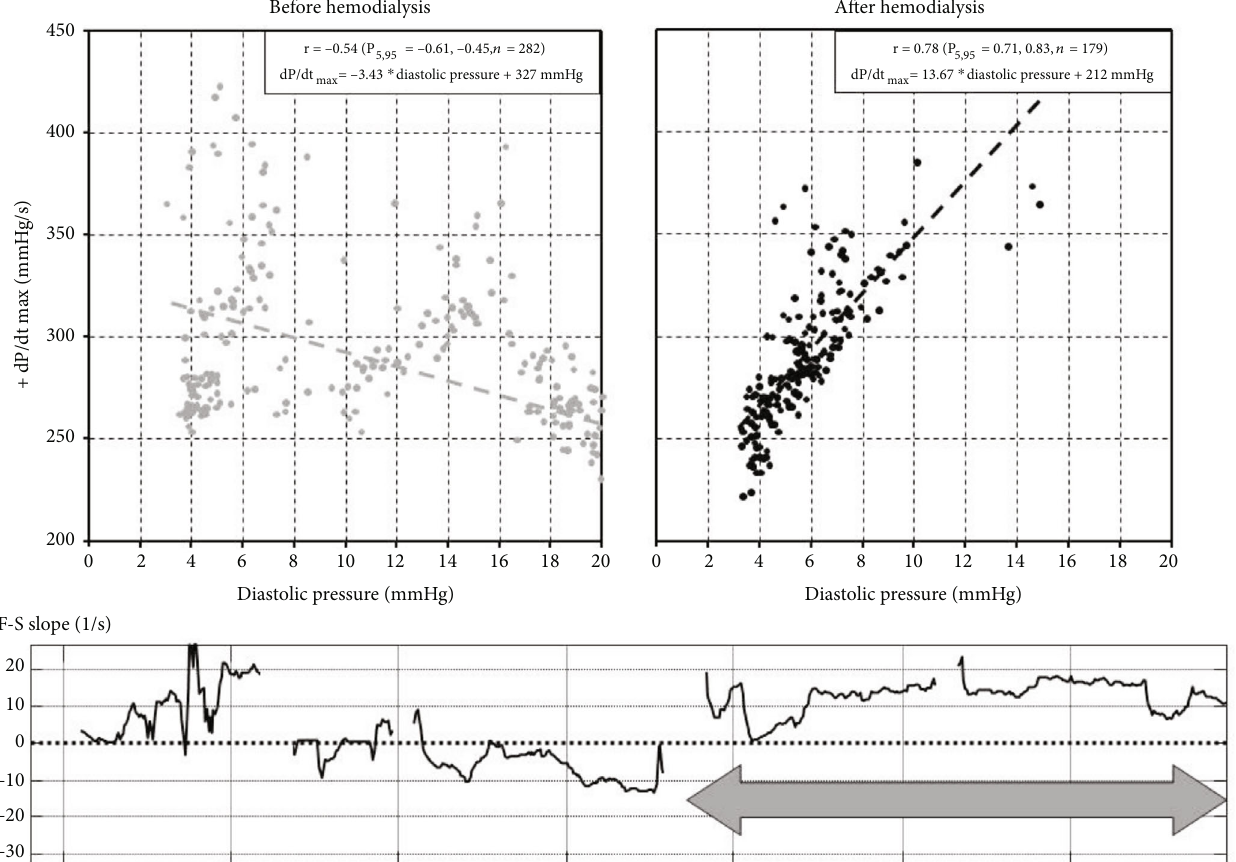
Figure 4: (a, b) Relation between maximum positive right ventricular dP/dt and diastolic pressure (ePAD). Two scatter diagrams show the relation between RV diastolic pressure (mmHg) and maximum dP/dt (mmHg/s) before ((a), grey) and after hemodialysis ((b), black). (c) Slope of the Frank-Starling curve obtained within a sliding window of 30 days. A positive F-S slope indicates an increase in maximum RV dP/dt (mmHg/s) at higher RV diastolic pressures (mmHg). Dashed lines indicate missing ePAD data. The arrow indicates the time frame of